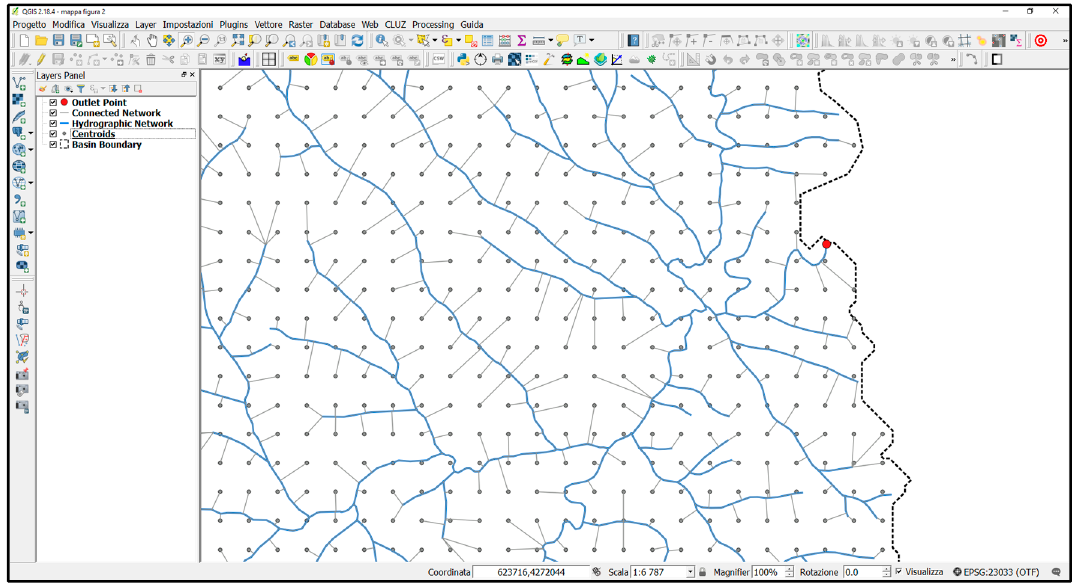
Figure 2. Result of the v.net.connect tool: new lines connecting centroids to stream network.